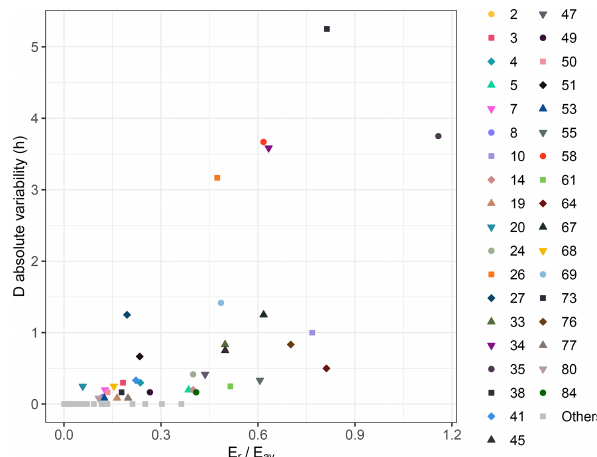
Figure 8. Positive correlation between the absolute variability of D and E r /E av , where E av is the rainfall volume per unit area avail- able in the main part of the hyetograph. The Spearman correlation coefficient is equal to 0 . 82 ( p < 2 . 2 × 10 − 16 ). To make the graph clearer, the events with absolute variability of D equal to zero are represented with the same symbol.